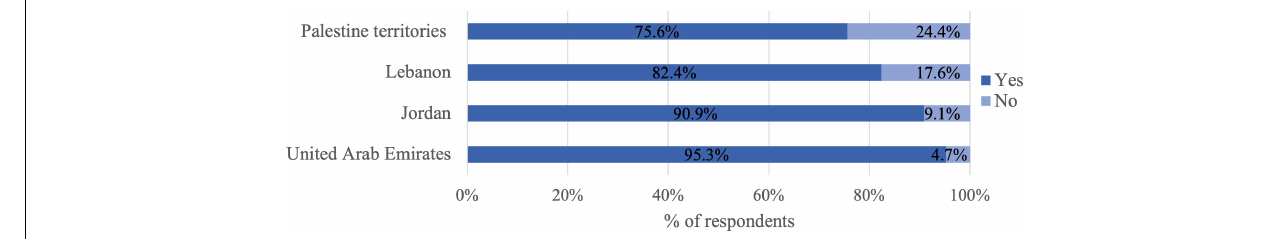
FIGURE 1 | Percentage of participants who have received at least one dose by country ( n = 2295).